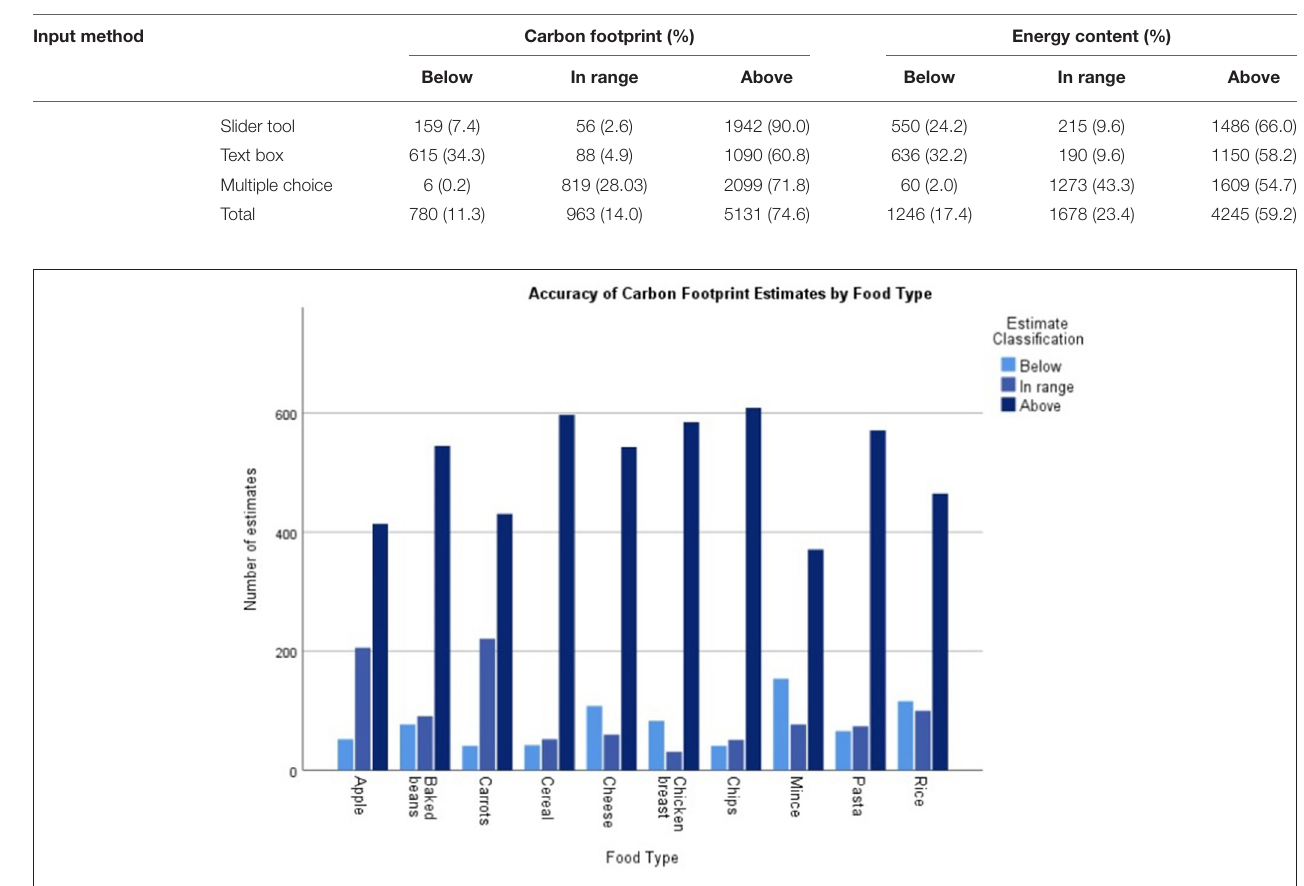
TABLE 2 | Accuracy of carbon footprint and energy content estimates for each data input method.